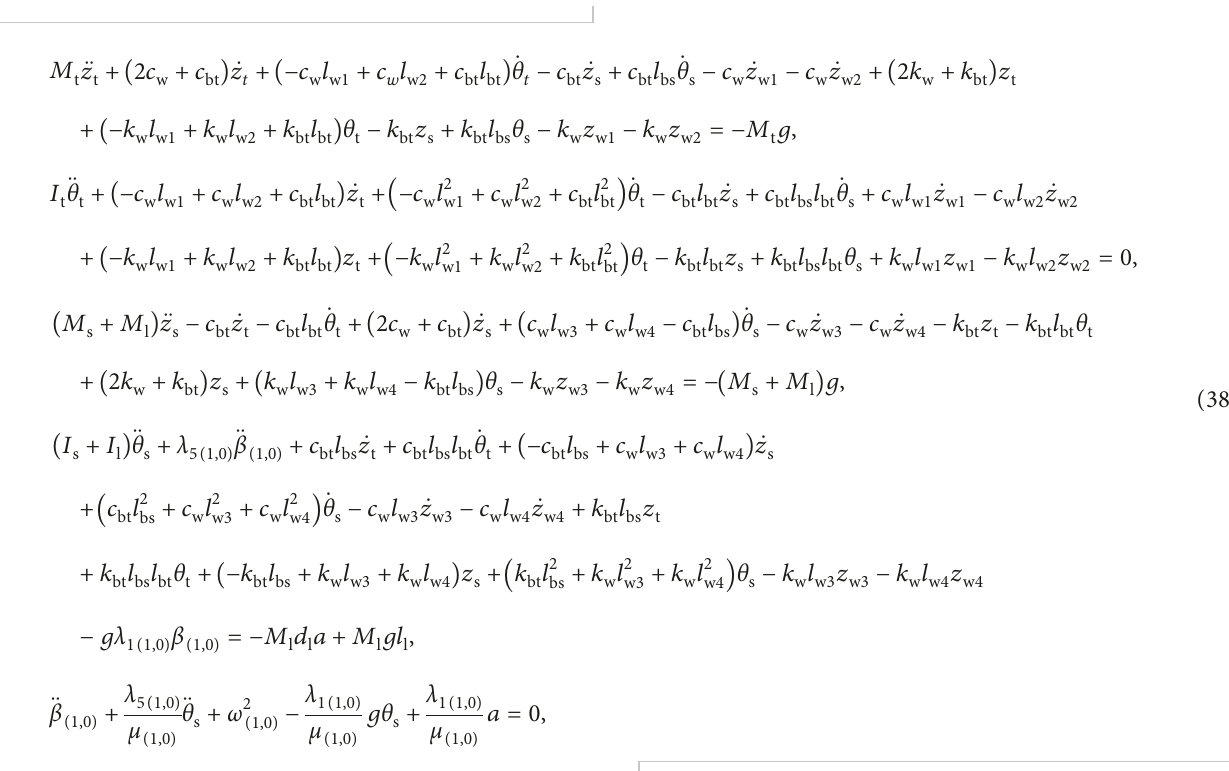
� 0.5 R ; (b) h � 1.0 R l l